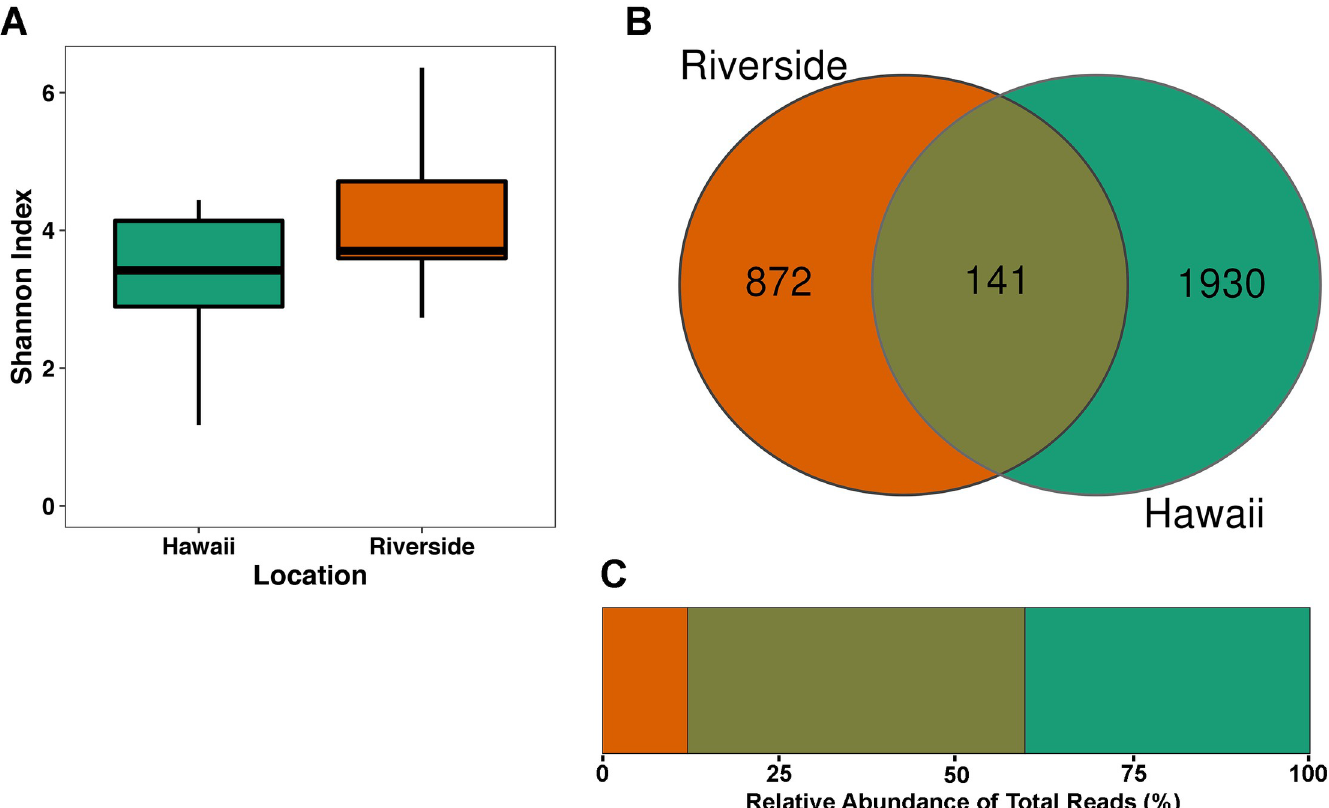
Fig 1. A) Boxplot of the Shannon diversities of wasp microbial communities from Riverside or Hawaii, which were not shown to be significantly different (H = 2.62, P = 0.11). B) Venn diagram showing the number of bacterial ASVs shared or unique between Hawaii and Riverside samples. C) Stacked barplot indicating the proportion of total reads shared or unique between Hawaii and Riverside